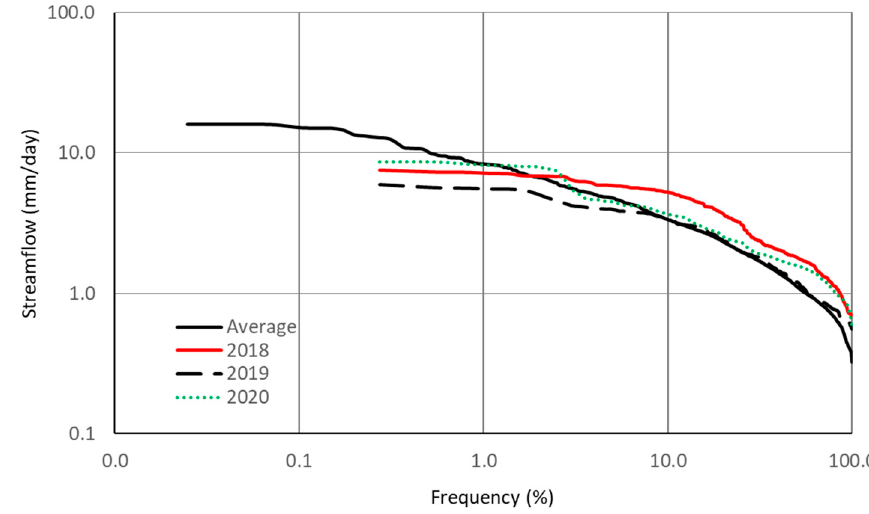
Figure 8. A comparison of streamflow flow duration curves for pre-Hurricane Michael (2007–2017) and the individual years following the disturbance event in 2018 in Chipola River Watershed.